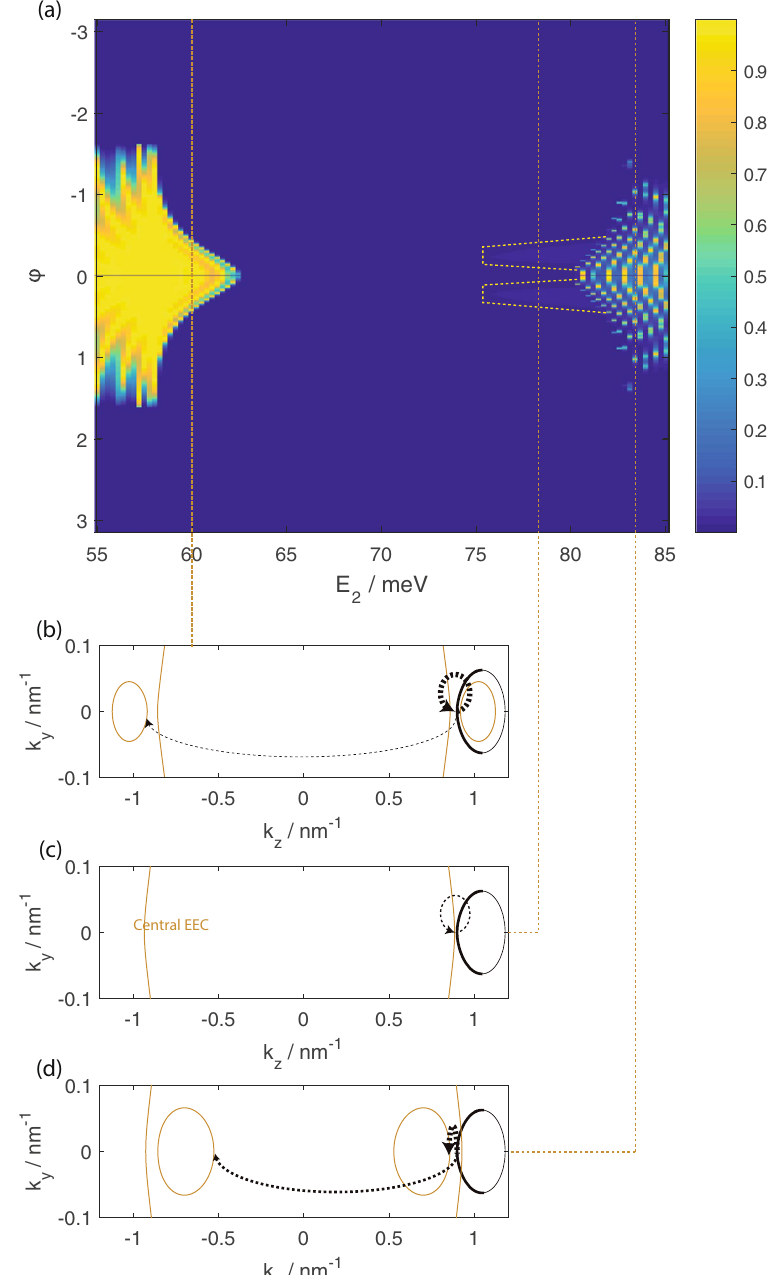
Figure 3. Panel (a) is the same plot of the transmission against angular coordinate as in Fig. 2(a). Panels (b) to (d) show the source (thick black lines) and central segment (thinner green lines) EECs at the indicated values of E 2 in panel (a). The relative thickness of the dotted arrows pointing from points on the source EEC to the central segment EEC at k y = 0 indicate the relative probabilities of the k y = 0 central segment states propagating in the + z direction the source k = 0 state gets transmitted into. The thicker sections of the source EECs correspond to y the source states which propagate in the + z